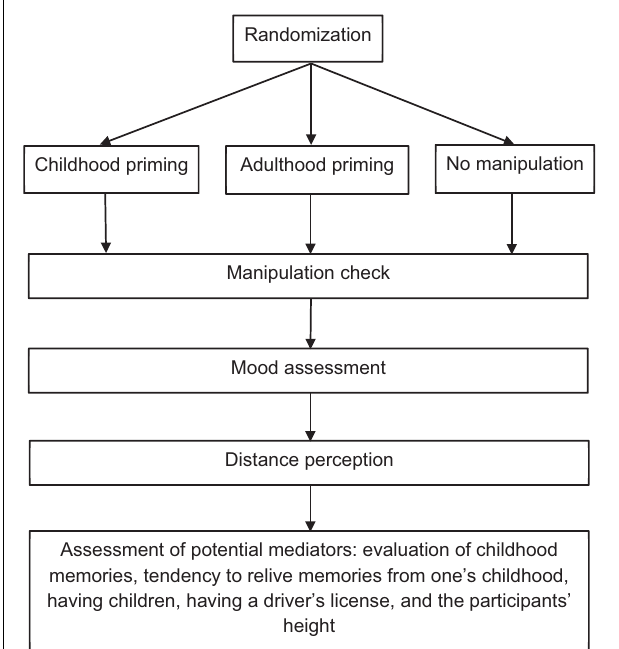
FIGURE 2 | Flowchart for Study 2.